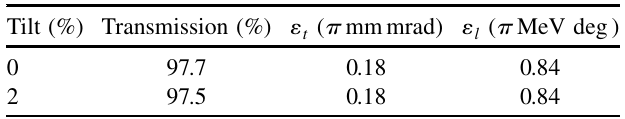
TABLE IV. PARMTEQM simulation results for field tilt. Here, " t is the normalized rms transverse emittance, and " l is the longi- tudinal